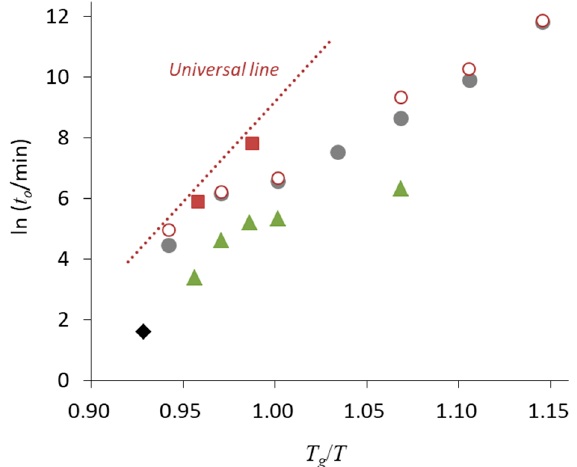
Figure 8. Onset crystallization time ( t o , min) of nifedipine glass as a function of T g / T . ( ■ ) After the pretreatment (see text), quenched in hermetically sealed pan (our data) [44]. ( ○ ) Quenched in sealed DSC pan without pretreatment (our data). ( ● ) Quenched in DSC pan [57]. ( ▲ ) Quenched on glass slides and crystallization was observed by polarized light microscopy [56]. Cracked glasses were excluded from the analysis. ( ◆ ) Quenched in DSC pan [58]. All the literature data were recalculated using the T g value of 45.5 °C. Definition of onset crystallization time, which is analogous to t 10 , is slightly different depending on literature, but its impact is ignorable in the analysis here.